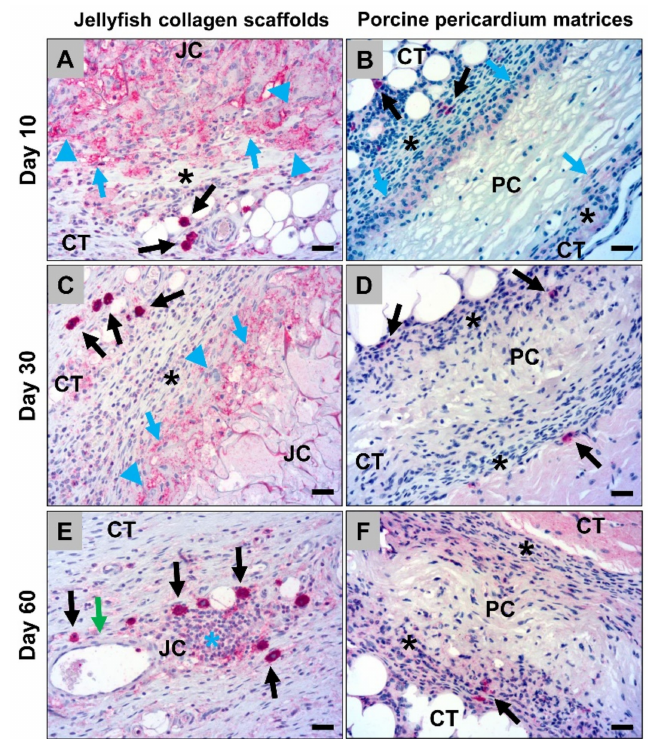
Figure 7. Representative histological images of the pro-inflammatory tissue response to the both analyzed biomaterials, i.e., the jellyfish collagen sca ff olds (JC) and the porcine pericardium matrices (PC) within the subcutaneous connective tissue (CT) based in immunohistochemical detection of the CD11c-expression at day 10 ( A , B ), day 30 ( C , D ) up to day 60 post implantationem ( E , F ). Black asterisks = cell walls at the material surfaces, blue asterisk = granulation tissue, black arrows = CD11c-positive macrophages within the surrounding connective tissue, blue arrows = CD11c-positive macrophages within the biomaterials (very slight expression), blue arrowheads = CD11c-positive multinucleated giant cells (slight expression), green arrow = blood vessels (CD11c-immunostainings, 20 × magnifications, scalebars = 20 µ